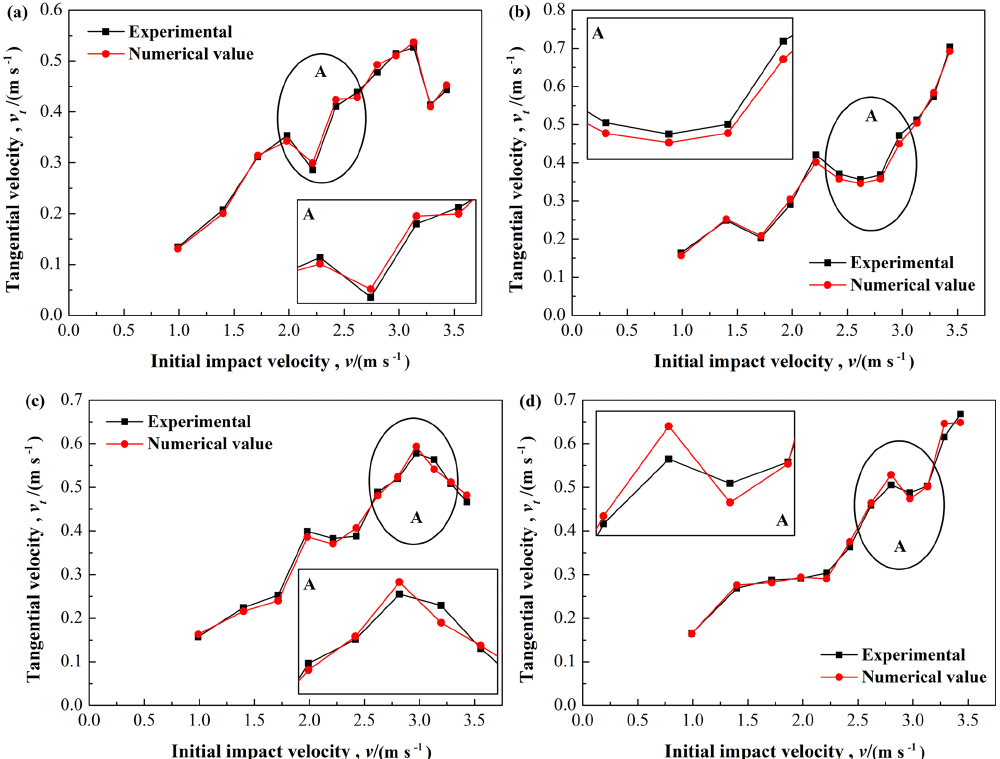
Figure 14. Comparison between the simulations and the experimental results for the rebound tangential velocity: (a) ξ = 1 / 8, (b) ξ = 1 / 2, (c) ξ = 3 / 4, and (d) ξ = 7 /